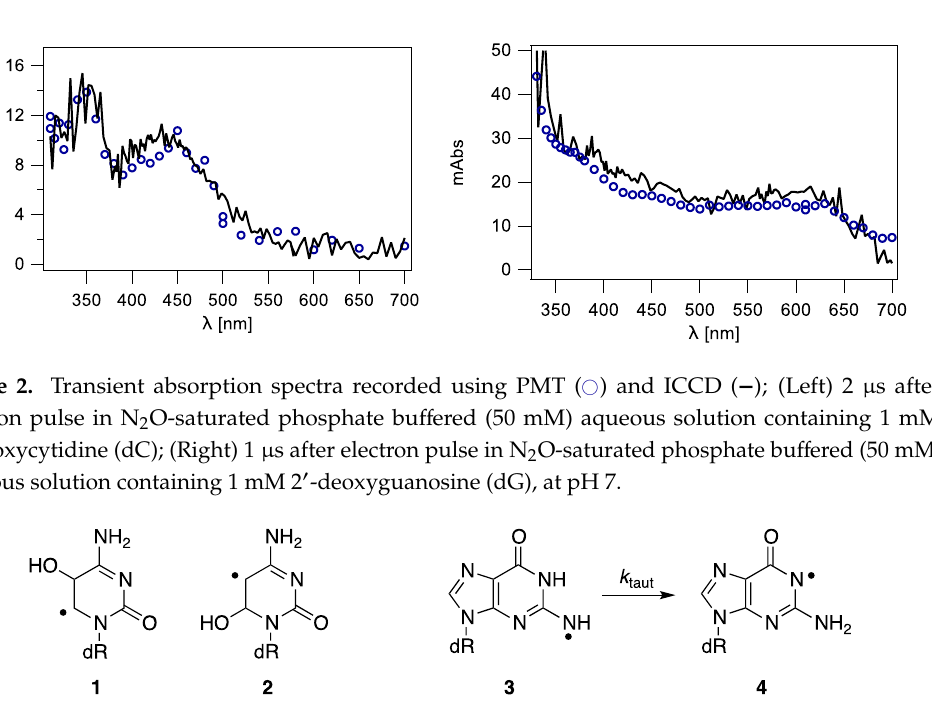
Figure 3. The main species generated by the reaction of HO • radical with dC and dG, respectively. Similarly, the spectral changes obtained by the two detection systems for 2′ -deoxyguanosine (purine representative) superimpose satisfactorily and are shown in Figure 2 (right panel). The optical absorption spectra taken 1 µ s after the pulse are characterized by a broad absorption band with a weakly marked maximum at λ max ~610 nm. This absorption band was earlier assigned to a guanyl radical 3 (Figure 3) formed by hydrogen abstraction from the exocyclic NH 2 with 65% yields, which undergoes further a water-assisted tautomerization to the most stable isomer 4 with a k taut = 2.3 × 10 4 s − 1 [23 – 25]. Moreover, the absorption spectra obtained are in agreement with those reported